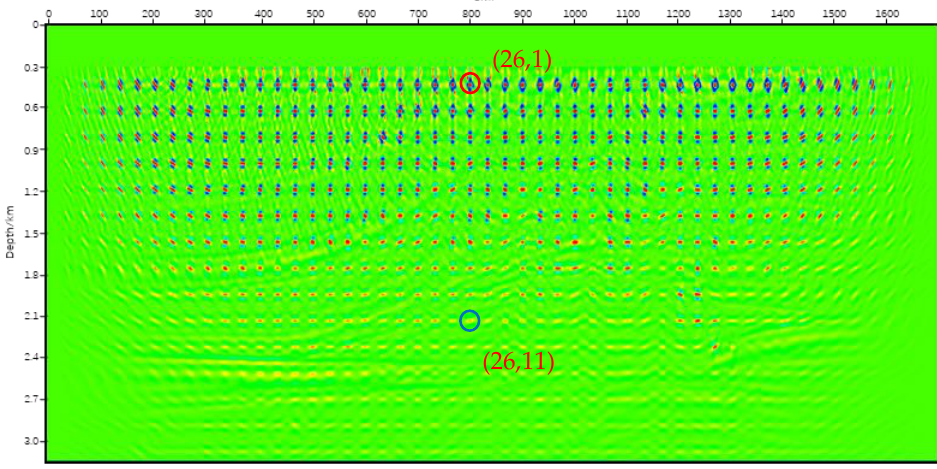
Figure 1. The global point spread function in the 2D Marmousi model.